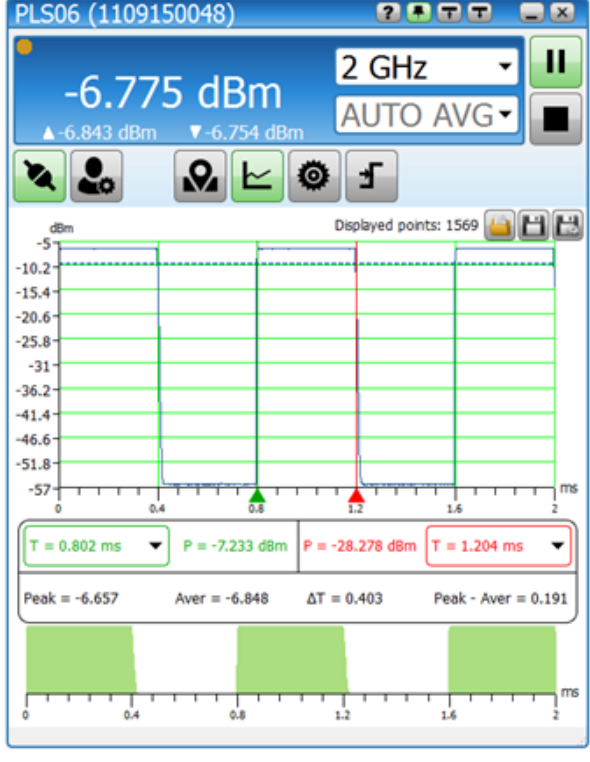
Fig. 7. The envelope of the modulated signal in PLS-client software.